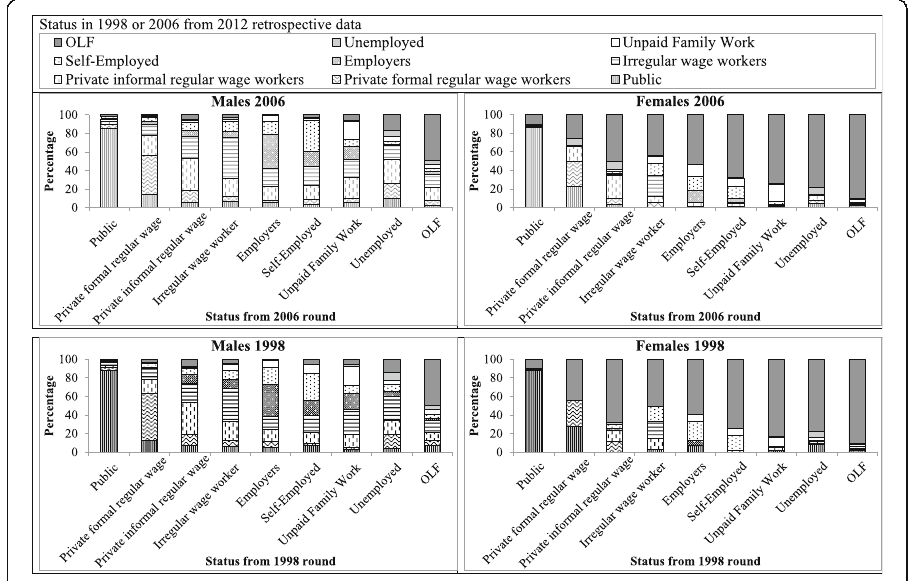
Fig. 5 Labor market status, as reported in 1998 or 2006 versus 2012 retrospective data for 1998 or 2006, by sex, individuals aged 20 – 44 in 1998 or 2006 and present in both waves (percentage). Source: Authors ’ calculations based on ELMPS 1998, ELMPS 2006 and ELMPS